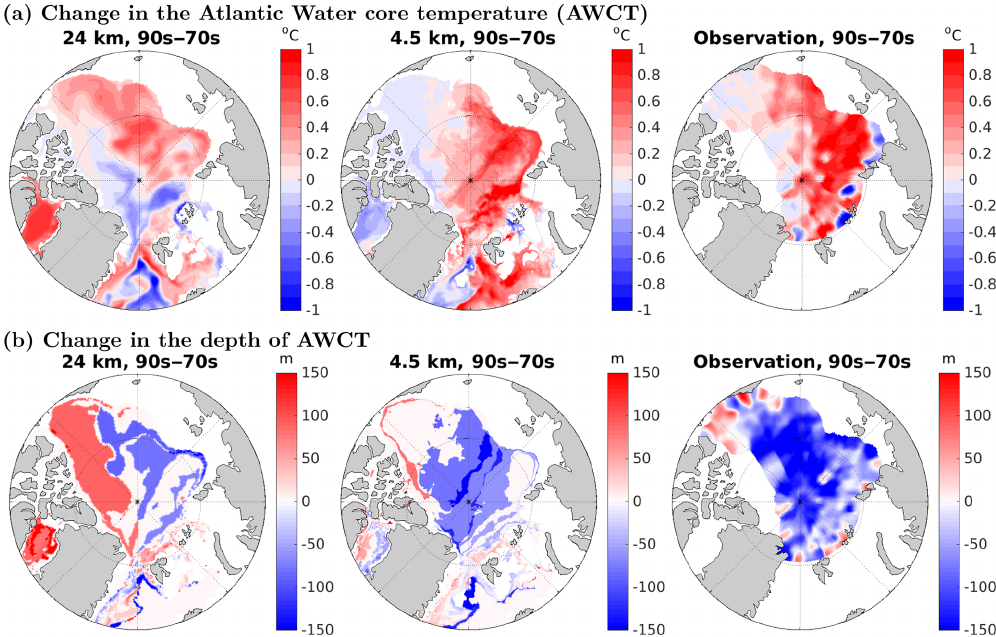
Figure 6. (a) Difference of the AWCT between the 1990s mean and 1970s mean (the former minus the latter) in simulations LOW and HIGH and in observations (from left to right). (b) The same as panel (a) but for the depth of the AWCT. For the model results, the shelf regions ( < 200m) are not shown. The observations of the two periods compared are derived from Polyakov et al.